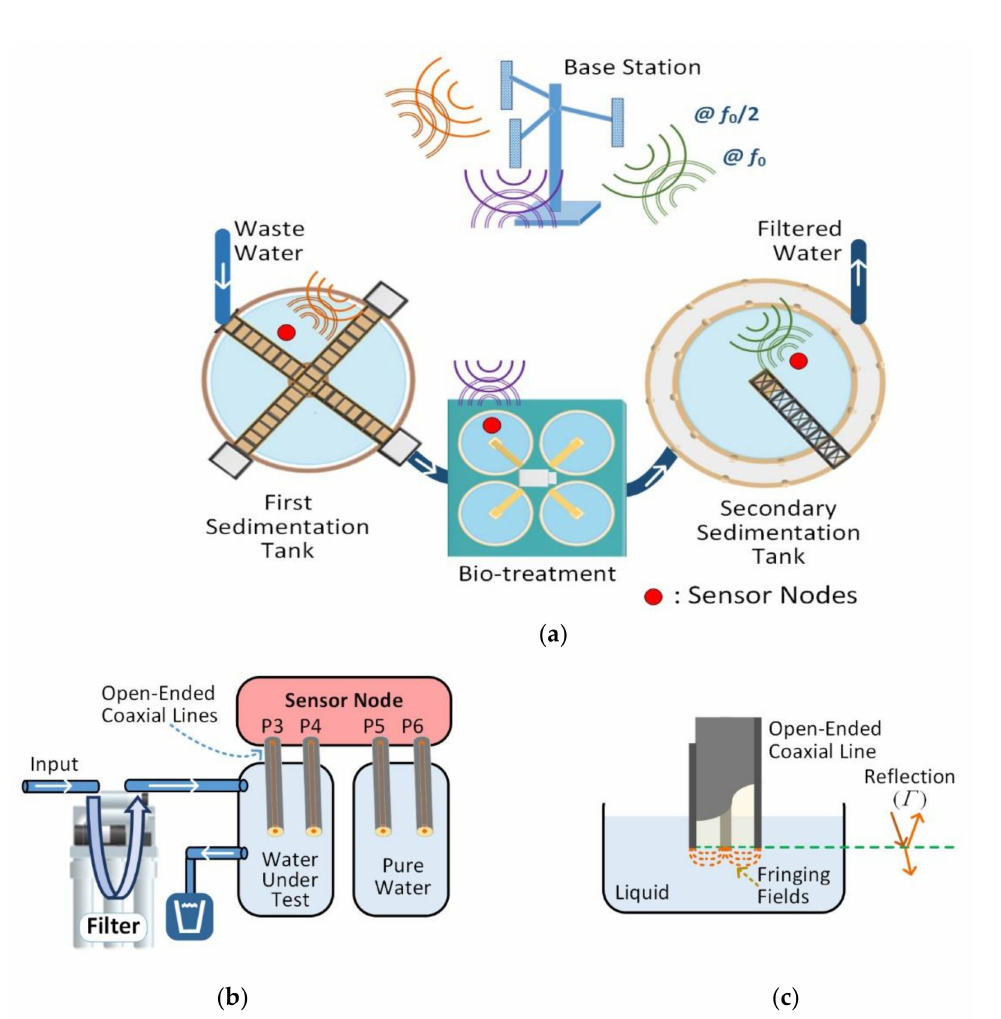
Figure 1. Schematic presentation of real-time water quality assessment: ( a ) A water sensor network; ( b ) A sensor node; ( c ) Open-ended coaxial line sensing of